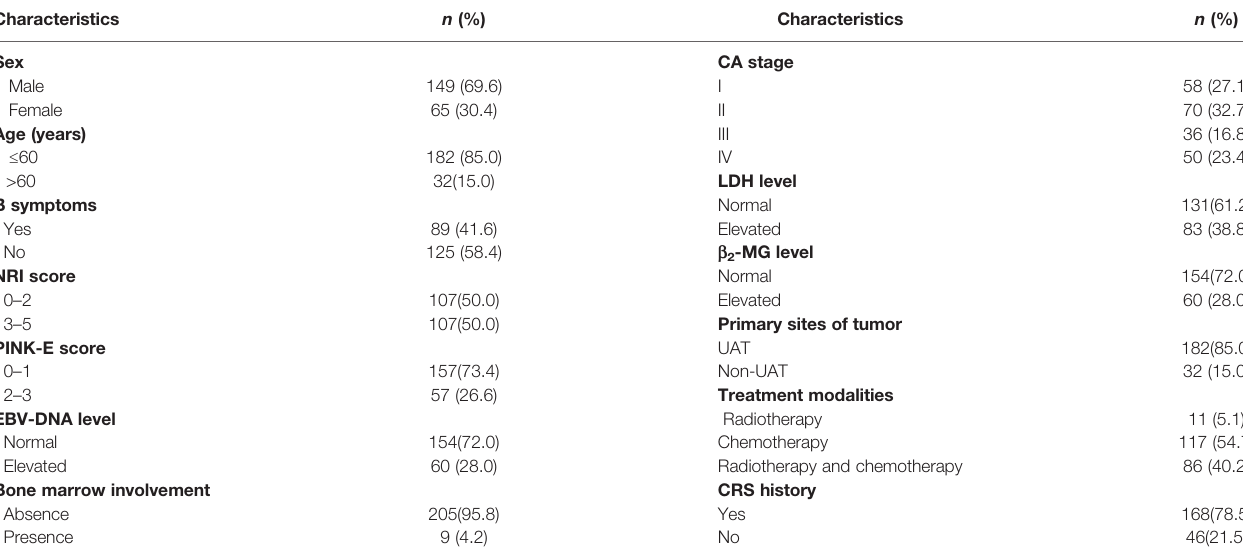
TABLE 2 | Characteristics of 214 ENKTL